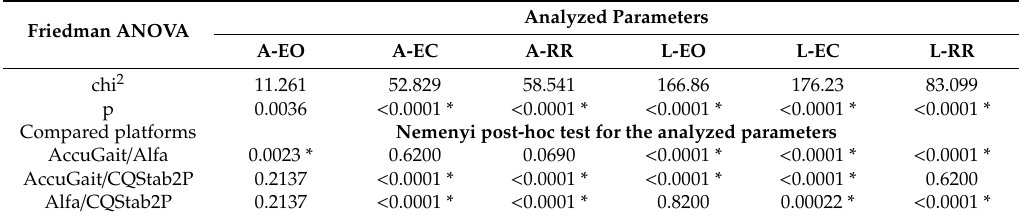
Table 3. Results of the Friedman analysis of variance (ANOVA) test for the analyzed platforms with the Nemenyi multiple comparison post-hoc test for all of the analyzed parameters. Friedman ANOVA